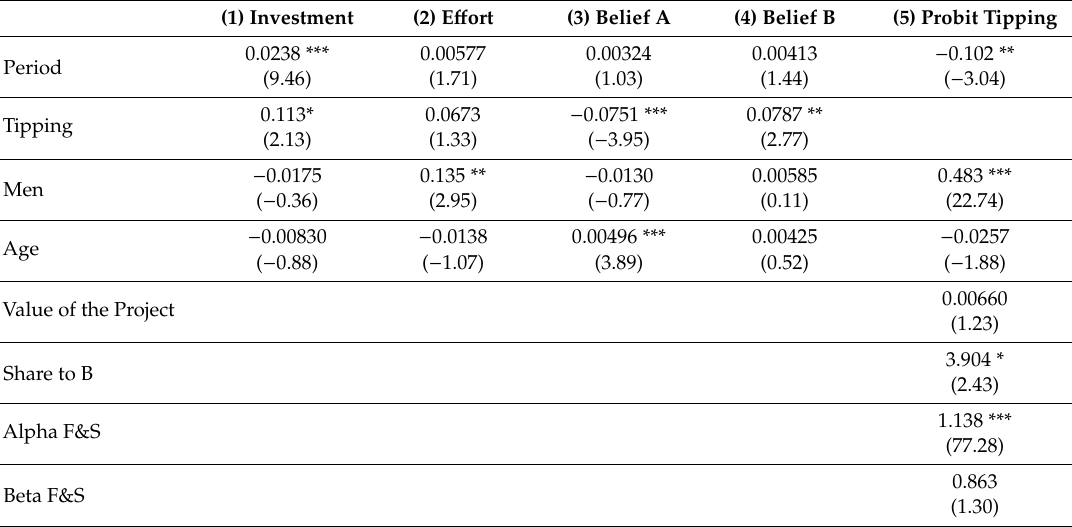
Table A4. Random GLS models for TIP decisions (1–4) and Probit model for tipping decision